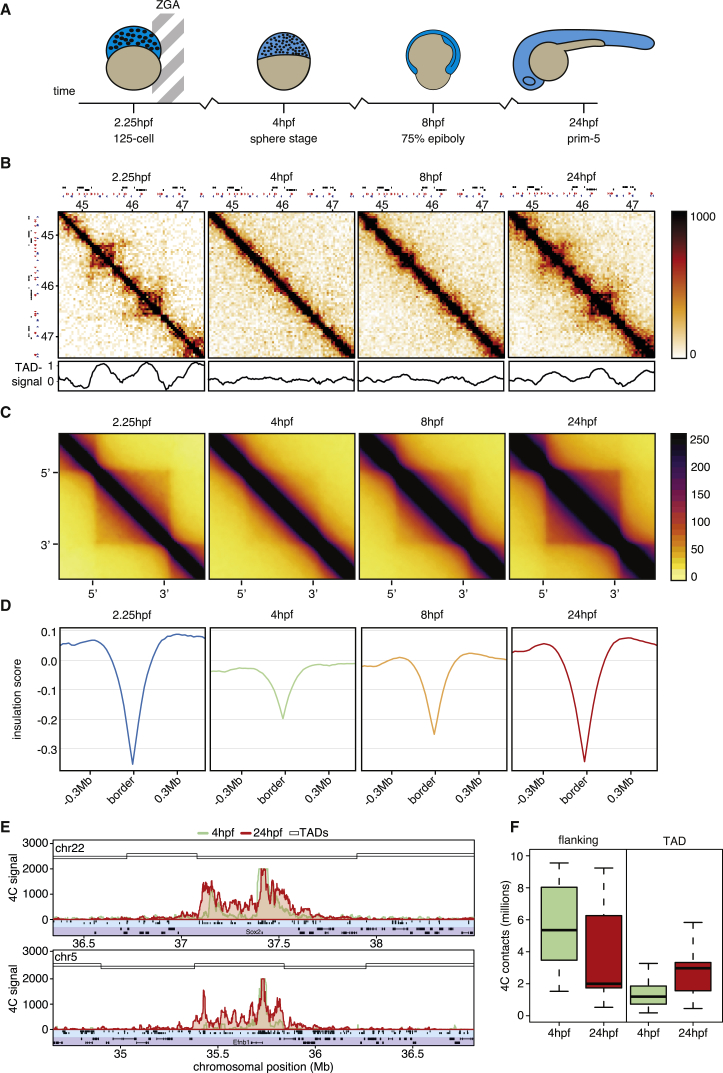
ZGA Is Accompanied by a Dramatic Loss of TAD Structure in Zebrafish(A) Schematic representation of the four developmental stages assayed by in situ Hi-C.(B) Zoom-in of a ∼4-Mb Hi-C contact matrix of chromosome 9 at 40-kb resolution, similar as Figure 1A. Below the plots, the TAD signal or insulation score is plotted. Insulation scores were calculated for Hi-C matrices with 20-kb resolution and a window size of 25 bins.(C) Aggregate TAD plots, based on TAD calls from 24 hpf, for all four Hi-C datasets. Hi-C data are the average of 2, 8, 9, and 4 biological replicates for 2.25-, 4-, 8-, and 24-hpf time points, respectively.(D) Insulation scores around 24-hpf TAD borders throughout zebrafish development, as indicated.(E) 4C-seq experiments show the contact frequency of the Sox2 TSS (upper panel) and an H3K27ac-enriched region (lower panel) at 4 hpf. The 24-hpf TADs are indicated in open rectangles. Below the 4C-seq plot, enhancers (light blue rectangle) and gene models (dark blue rectangle) are depicted.(F) Boxplot showing the quantification of the contact frequency in the 15-kb region flanking the viewpoint and the rest of the TAD measured in 11 4C-seq experiments at 4 and 24 hpf (p = 0.00054, paired Wilcoxon rank sum test, for flanking region comparison).Primers for the 4C viewpoints can be found in Table S1.